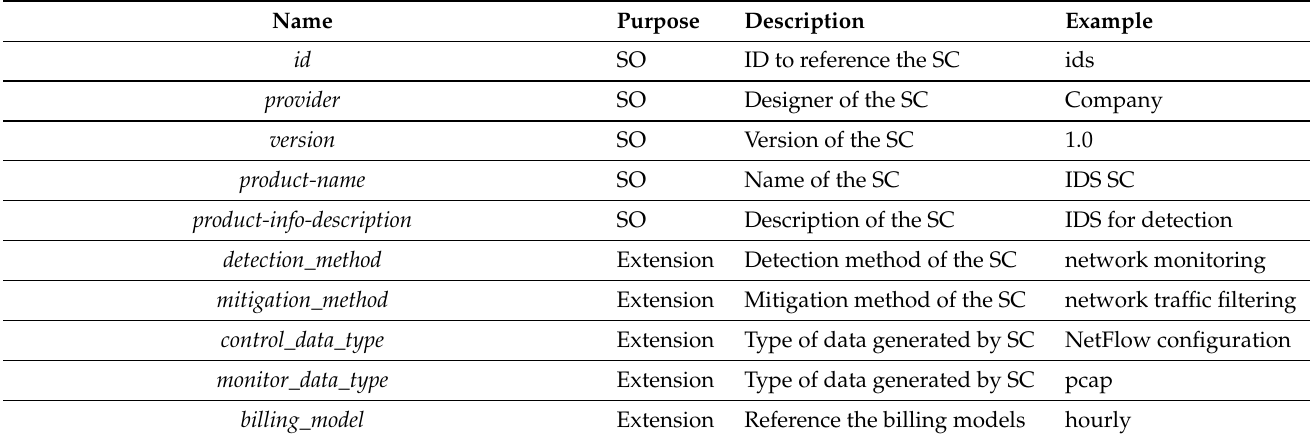
Table 1. Security Capability entry model